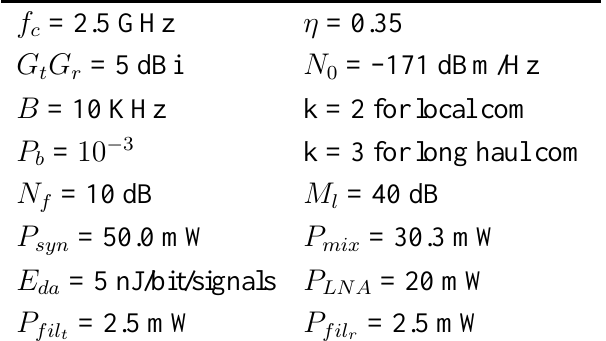
Figure 6. Total energy consumption over